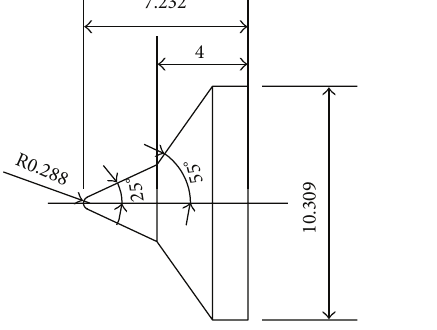
Figure 6: Number 3 configuration (in) (R0.288 blunt nose 25 ∘ /55 ∘